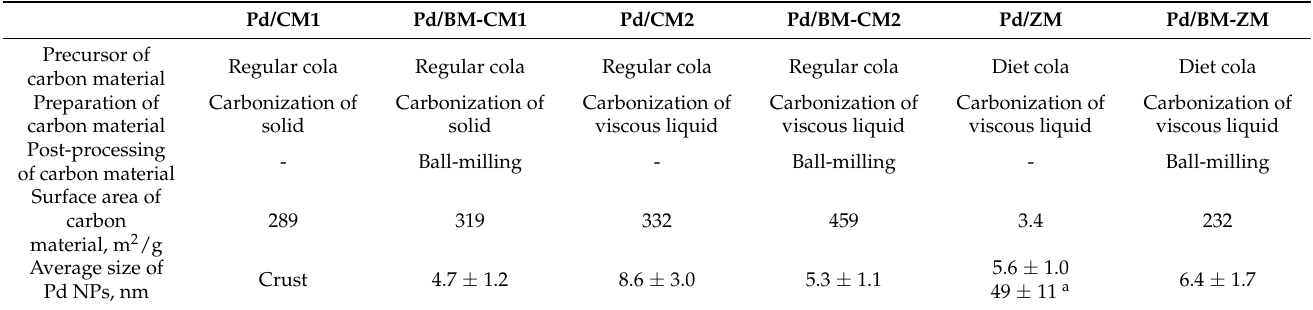
Table 1. Preparation procedures, surface areas of prepared carbon materials and average size of deposited palladium